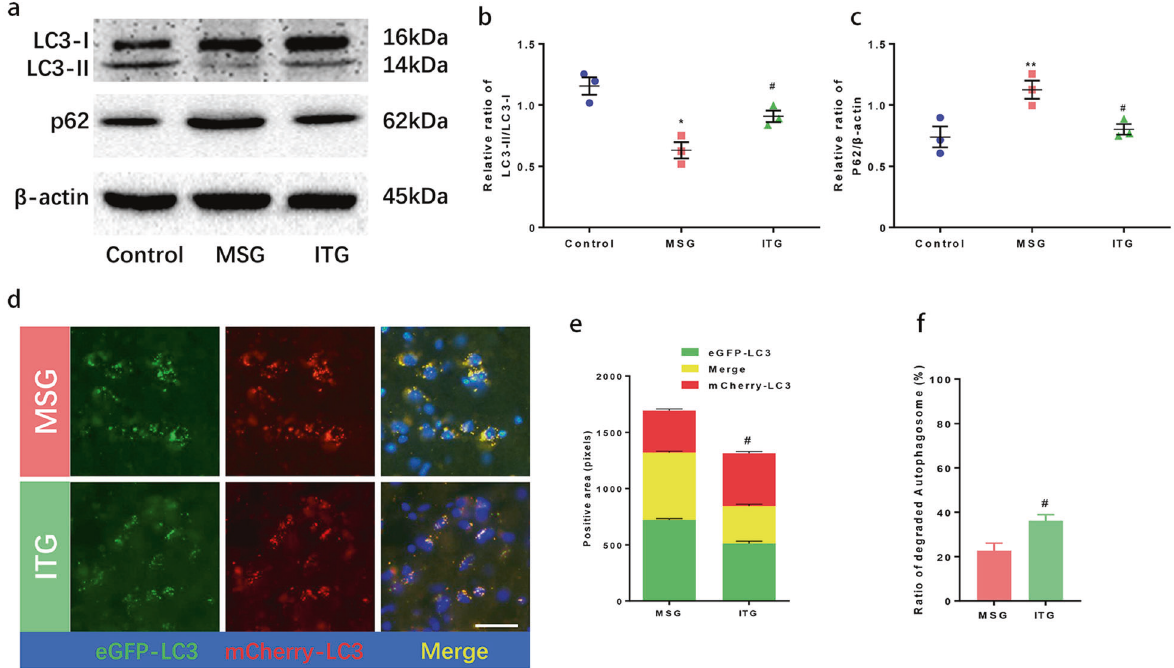
Fig. 3 Effects of idebenone on autophagy in substantia nigra neurons. a Protein immunoblotting at the levels of LC3 and p62 in mouse midbrain substantia nigra. b Statistical analysis of LC3II/LC3I protein levels in the substantia nigra of mice. c Statistical analysis of protein quantity at p62 level in mouse midbrain substantia nigra. d LC3 immuno fl uorescence in substantia nigra of eGFP-mCherry-LC3 mice: green fl uorescence eGFP-LC3, red fl uorescence mCherry-LC3, yellow fl uorescence merge. Bar = 100 μ m. e Fluorescence intensity statistics of LC3 neurons in the substantia nigra of eGFP-mCherry-LC3 mice. f Ratio of autophagosomes that were successfully degraded * P < 0.05, ** P < 0.01 vs. control, # P < 0.01 vs. MSG, N = 3. Cell Death Discovery (2022)